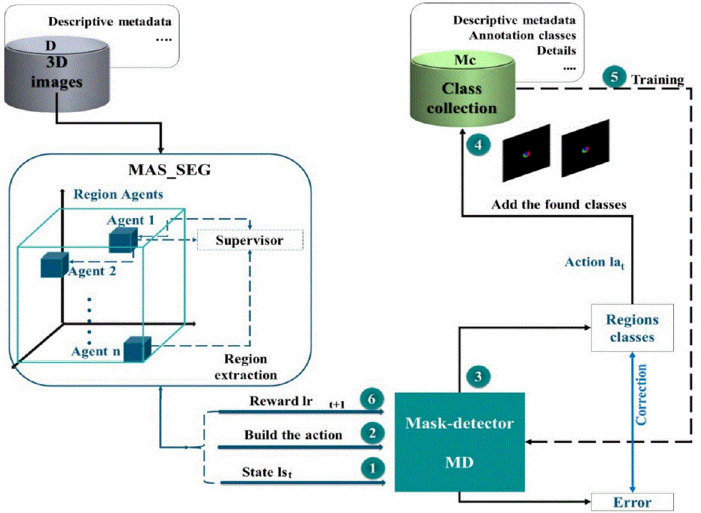
Figure 10. Architecture of 3D mask detection using MARL approach [78].